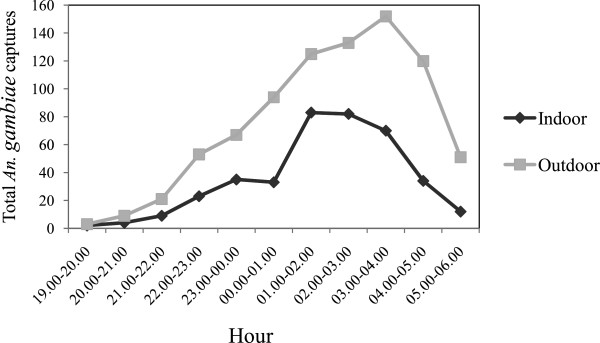
Hourly biting patterns of An. gambiae s.s. by Human Landing Catches during the dry season.